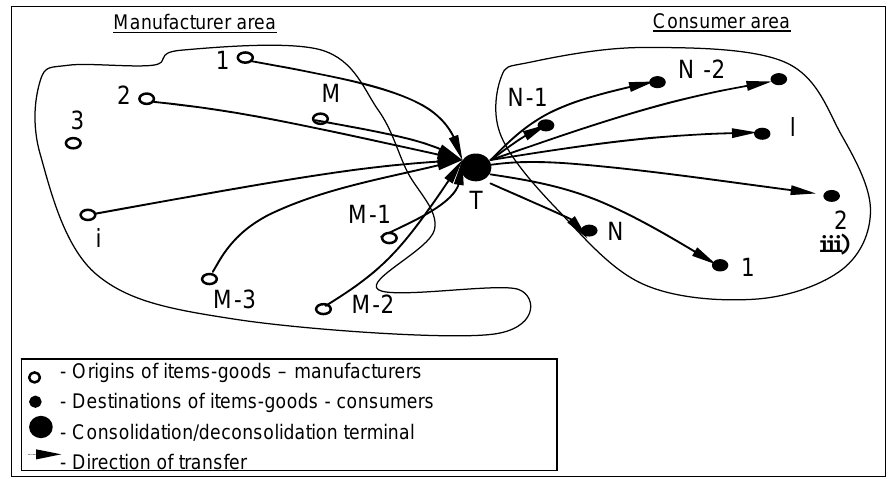
Figure 3. A simplified scheme of three transport network configurations serving a given logistics network As can be seen, the manufacturers (white circles denoted by index (i) ) are clustered in the “manufacturer area”. The retailers/consumers (black circles denoted by index (j) ) are clustered in the “consumer area”. These both represent the network nodes where the goods’ flows originate and destine, respectively. The arrows indicate the direction of movement of these goods (Janic,